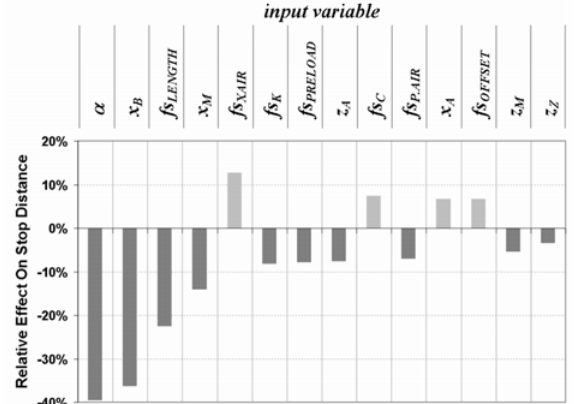
Fig. 8. Student chart: Effects of design parameters on